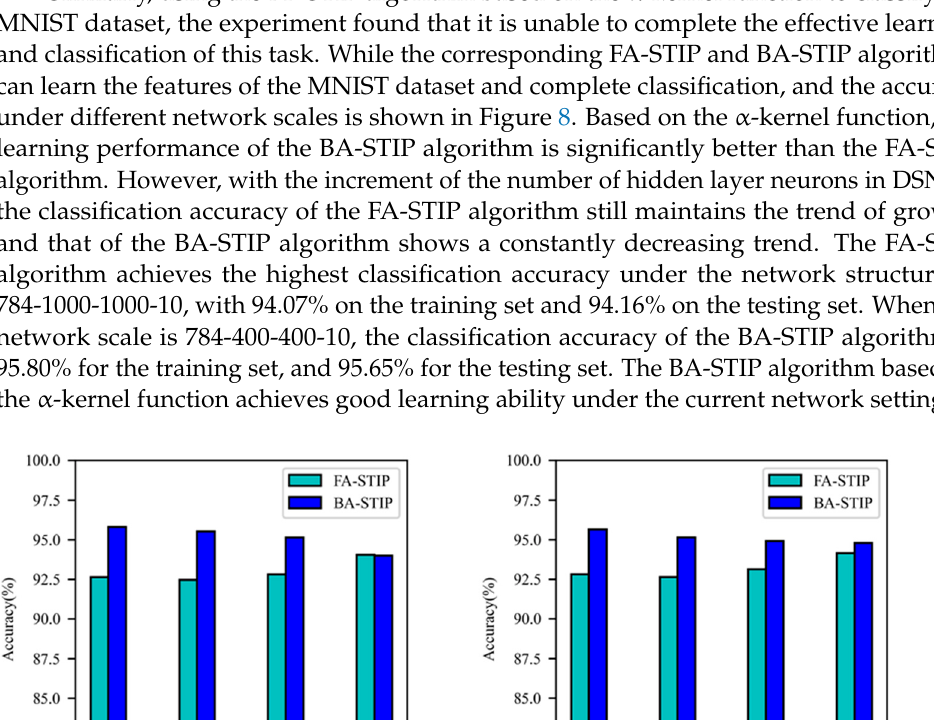
Figure 8. Comparison of learning performance for three STIP ‐ based algorithms with α‐ kernel func ‐ tion. ( a ) The accuracy of the training set; ( b ) the accuracy of the testing set. function. ( a ) The accuracy of the training set; ( b ) the accuracy of the testing